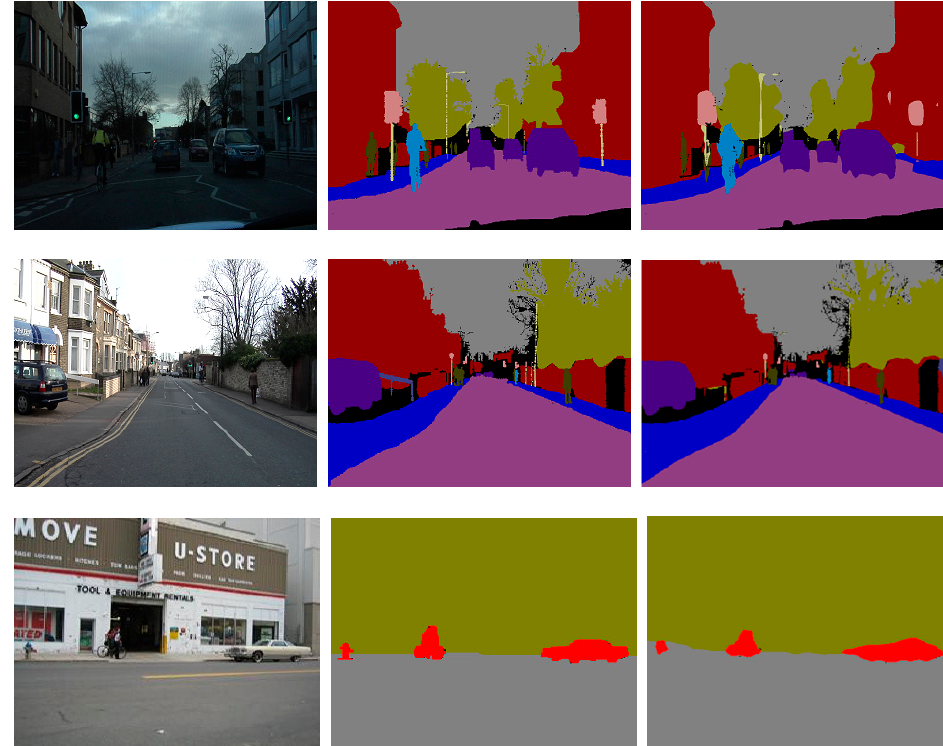
Figure 6. Detected results by proposed method. The images in the 1st and 2nd rows are from CamVid and those in the 3rd row are from SBD. In each row, input, ground-truth, and detected result are respectively shown from the left. Class information is shown in Figure 4. respectively shown from the left. Class information is shown in Figure 4.